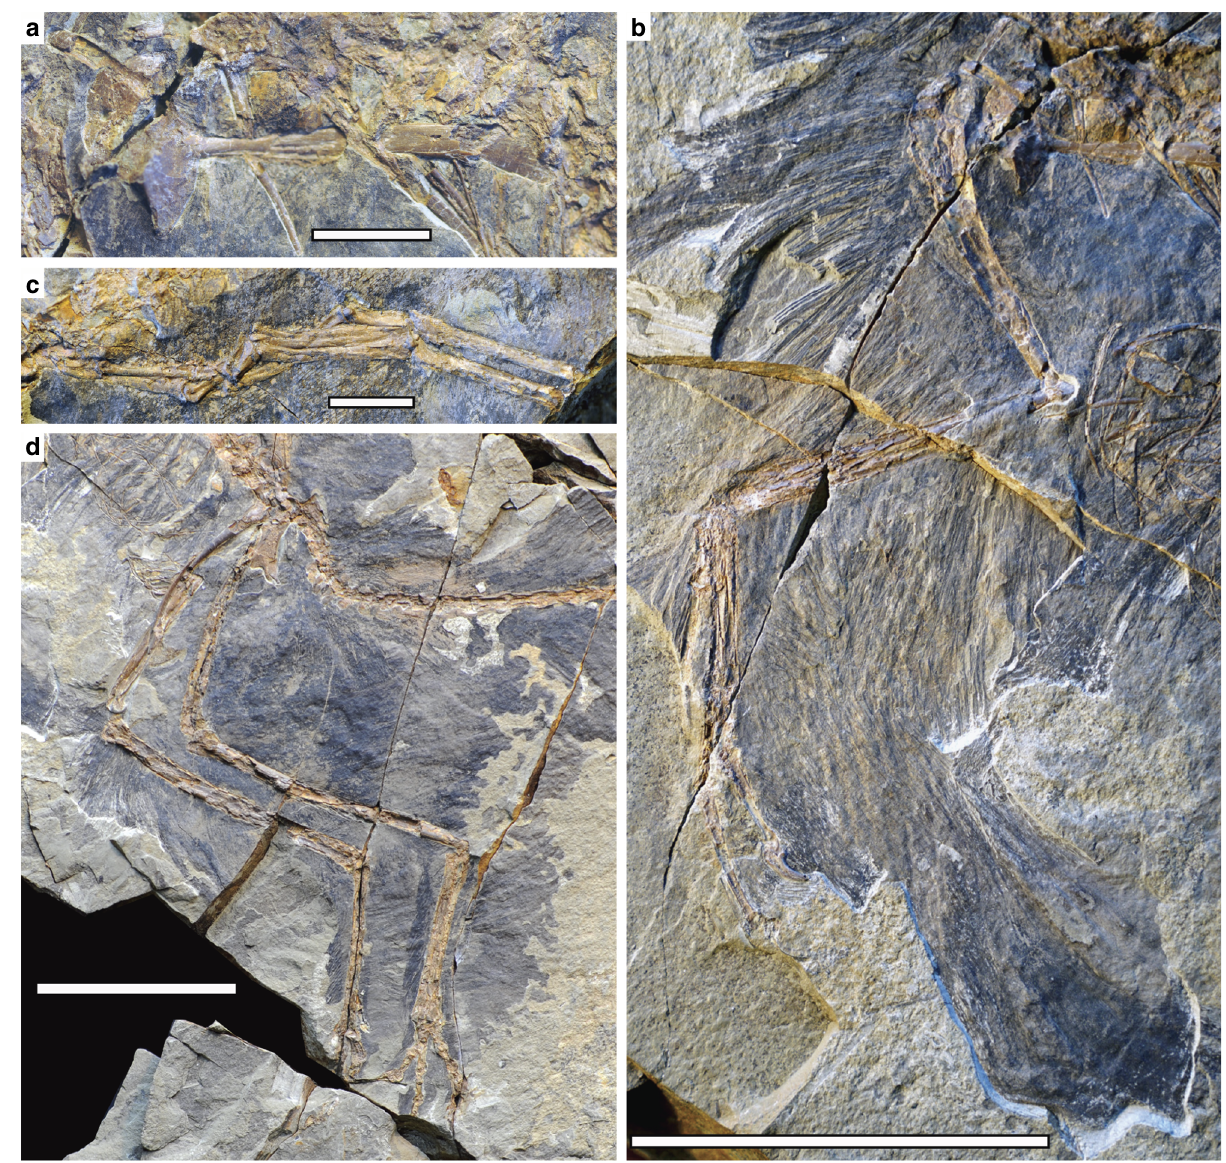
Fig. 3 Photographs of the pectoral girdle and limbs of Caihong juji . a Right scapula and coracoid in medial and proximal views; b right forelimb; c left manus; d left and right hind limbs. Scale bar: 1 cm in a , c , and 5 cm in b ,